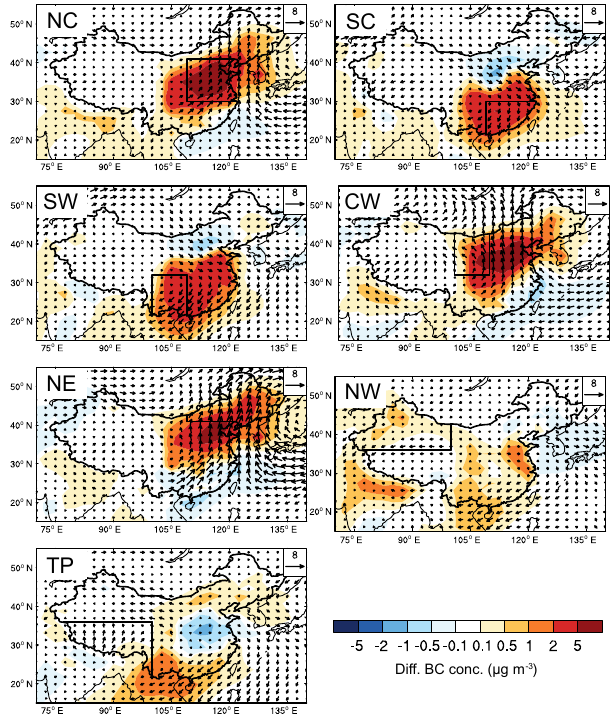
Figure 8. Composite differences in winds at 850hPa (ms − 1 ) and near-surface BC concentrations (µgm − 3 ) between polluted and normal days in DJF.